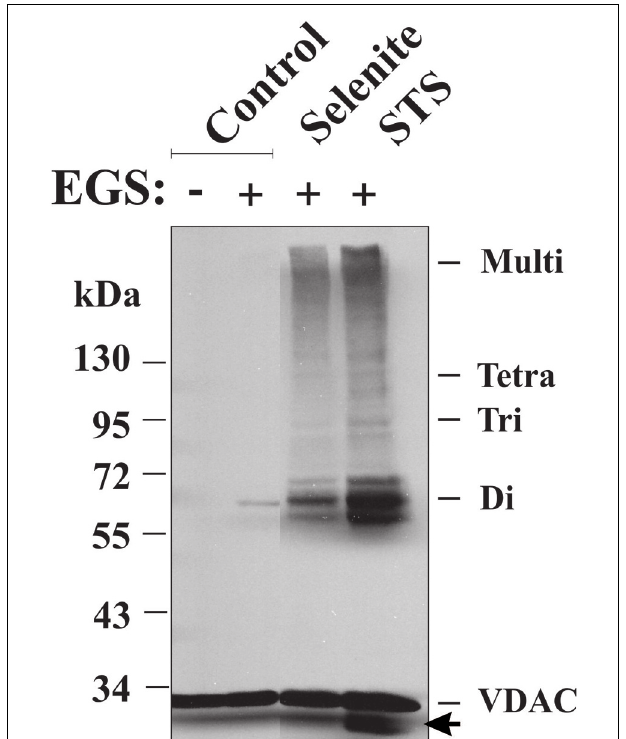
FIGURE 5 |Apoptosis induction andVDAC1 oligomerization. VDAC1 oligomerization as induced by apoptosis inducers and revealed by EGS-based cross-linking. HeLa cells were incubated for 16 h with STS (0.2 μ M) or selenite (8 μ M), as described previously (Keinan etal., 2010), washed with PBS and incubated with EGS (300 μ M) at 30 ◦ C for 10 min, followed by SDS-PAGE (10% acrylamide) andWestern blotting using anti-VDAC1 antibodies.VDAC1 monomers, dimers, trimers, tetramers, and multimers are indicated.The arrow indicates an anti-VDAC1 antibody-labeled protein band migrating below the position of monomeric VDAC1.The positions of molecular weight protein standards are also